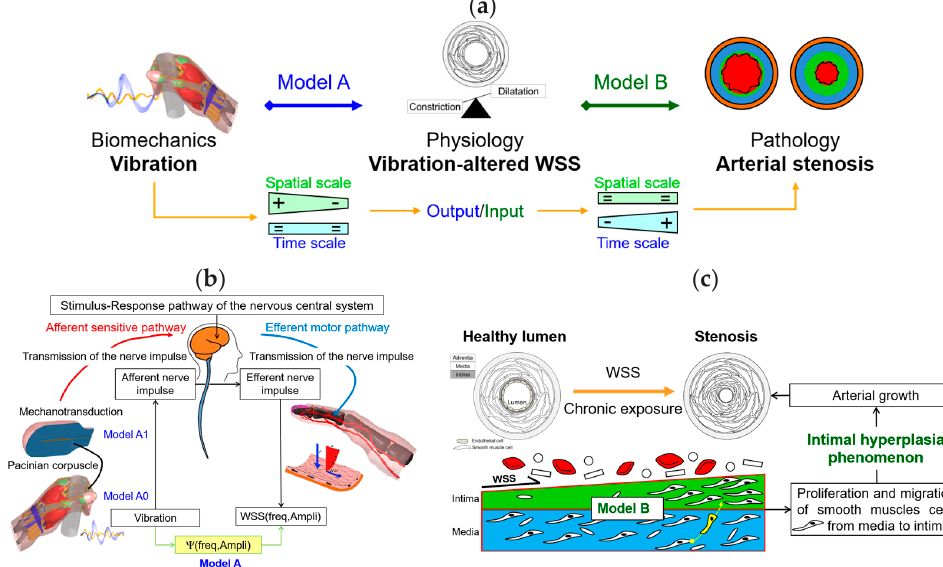
Figure 2. ( a ) Diagram of our original strategy; ( b ) details of model A; ( c ) details of model